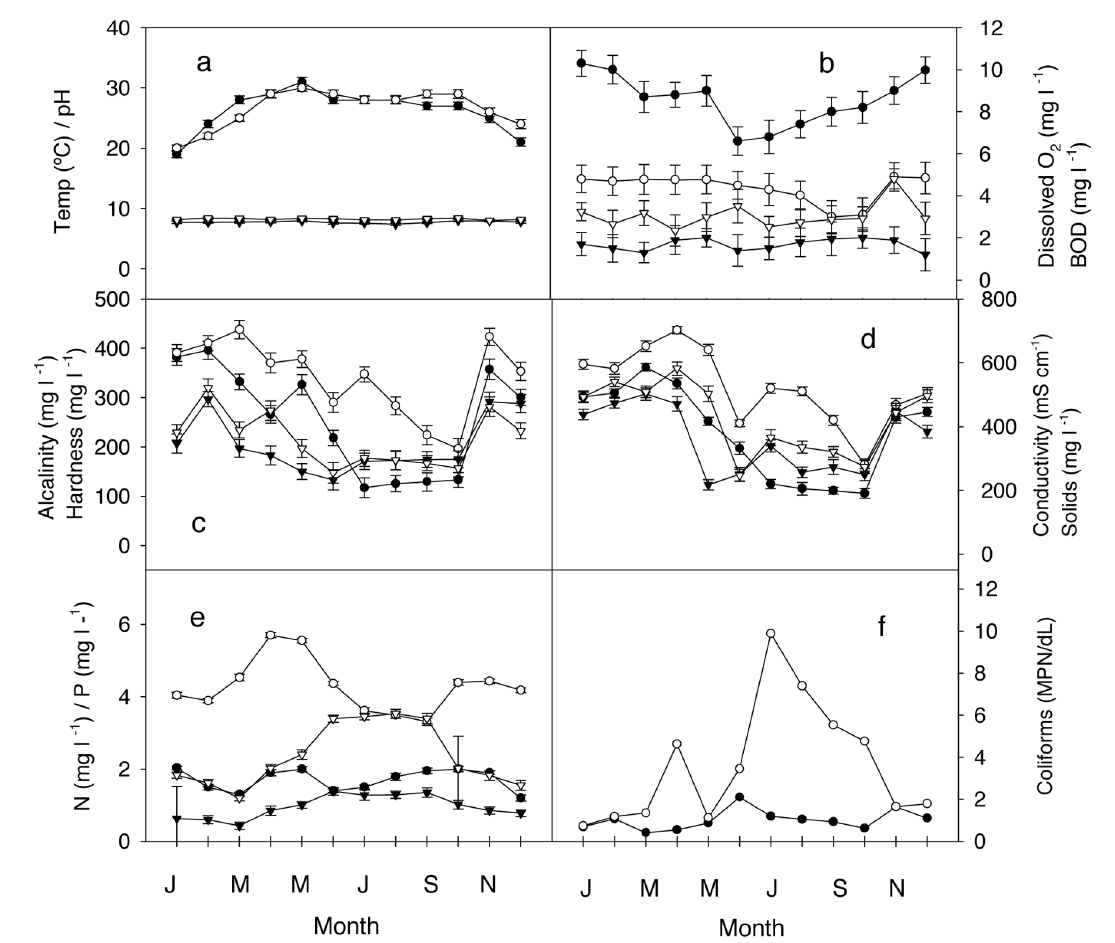
Fig. 2. Monthly means of environmental data in rivers Jalangi (solid symbols) and Churni (open symbols) in NE India. (a) Water temperature (circle) and pH (triangle). (b) Dissolved oxygen (circle) and biological oxygen demand (triangle). (c) Alcalinity (circle) and hardness (triangle). (d) Electrical conductivity (circle) and total solids (triangle). (e) Total nitrogen (circle) and phosphorus (triangle). (f) Coliforms. Standard errors shown when larger than